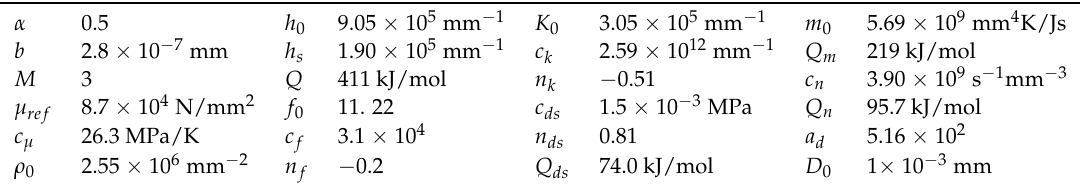
Table 1. Model parameter values. Fitted by least squares optimization to the hot compression stress–strain data of Zhang et al.